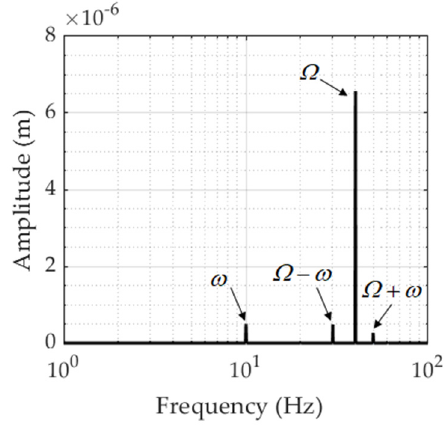
Figure 4. FFT result of the simulated displacement of Bearing 1 in the X -direction.